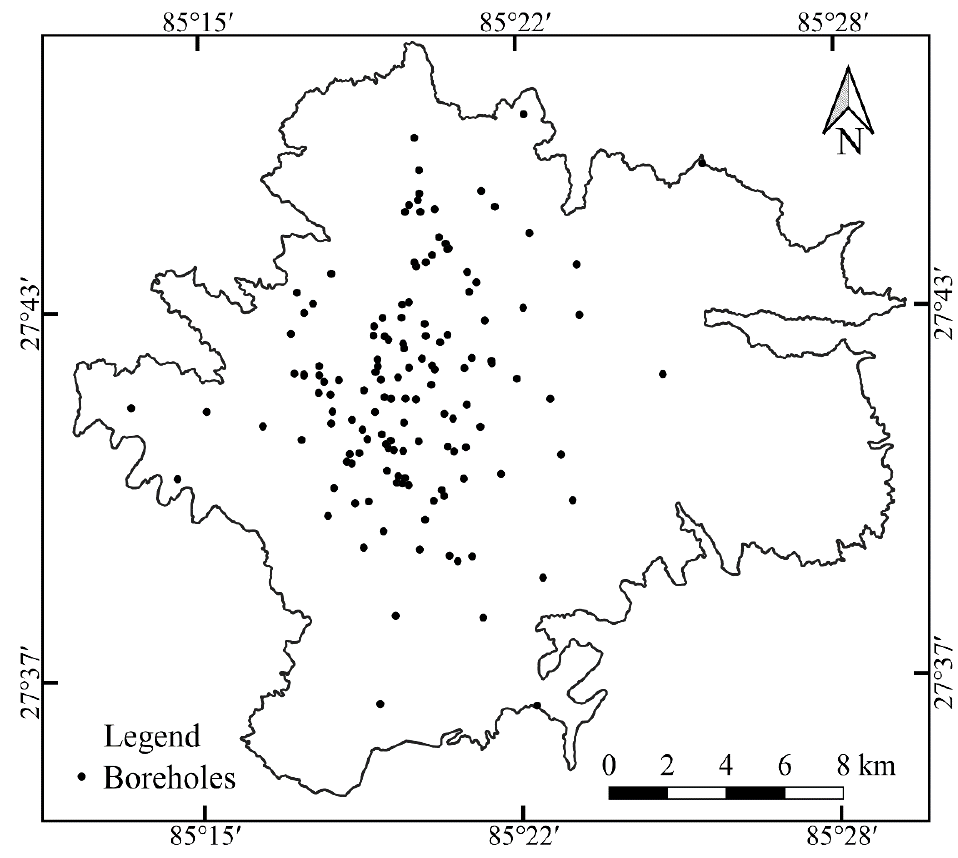
Figure 4. Boreholes considered in the study.